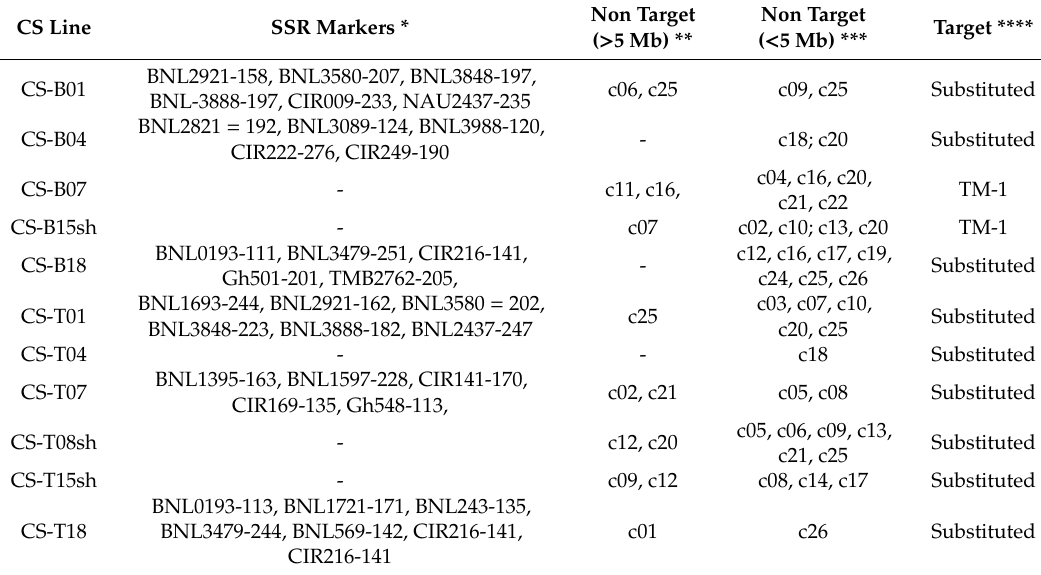
Table 4. Classification of 11 CS lines (chromosome-specific introgressions from G. barbadense and G. tomentosum into Upland cotton ( G. hirsutum , cv. TM-1)) into drought-, heat- and heat